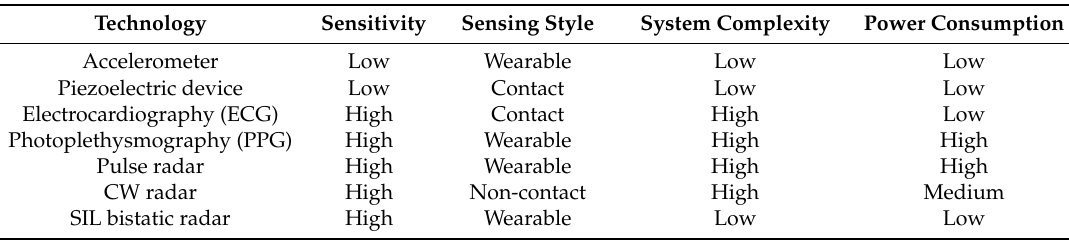
Table 1. Comparison of vital-sign sensing